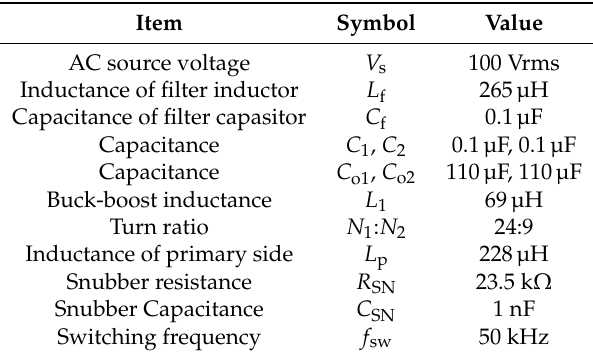
Figure 7. Relationship between the power flows and voltage ripple of the smoothing capacitor. Table 1. Circuit constants of the proposed LED